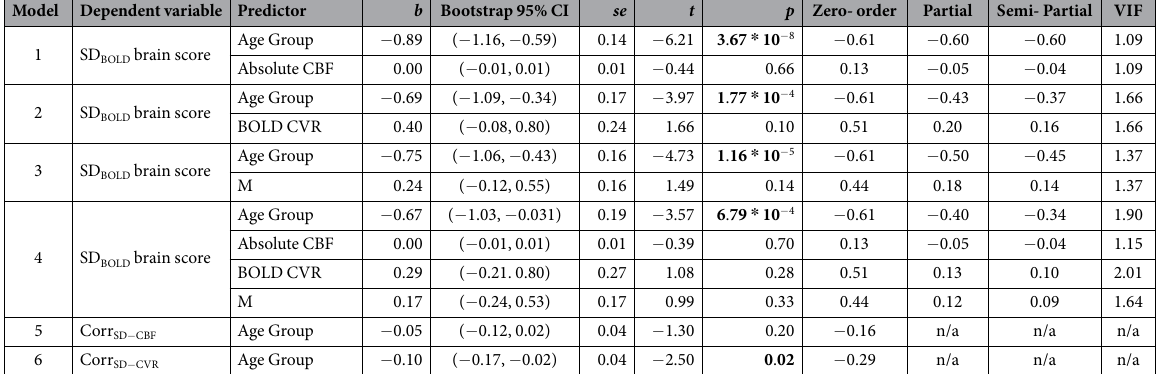
Table 2. Univariate models. Note: SD = standard deviation; CI = confidence interval; BOLD = blood oxygen level-dependent; YA = young adults; OA = older adults; CBF = cerebral blood flow; CVR = cerebrovascular reactivity; M = maximal BOLD signal change; VIF = variance inflation factor. Significant p -values are in bold font. “Zero-order”, “partial,” and “semi-partial” columns reflect effect sizes in Pearson’s correlation metric. Levene’s test for equality of variances was insignificant in all models ( p s ranged from 0.12 to 0.95). Finally, the frequency of males and females was significantly different in the young (20 male, 8 female) and older (11 male, 32 female) groups (Chi square = 14.49, p = 1.41 * 10 − 4 ); however, sex had no predictive effect in any model reported above (all p s ranged from 0.21 to 0.52), and also had no appreciable effect on the unique effect of any predictor of interest. We thus report all final models above without further control for participant sex. Finally,